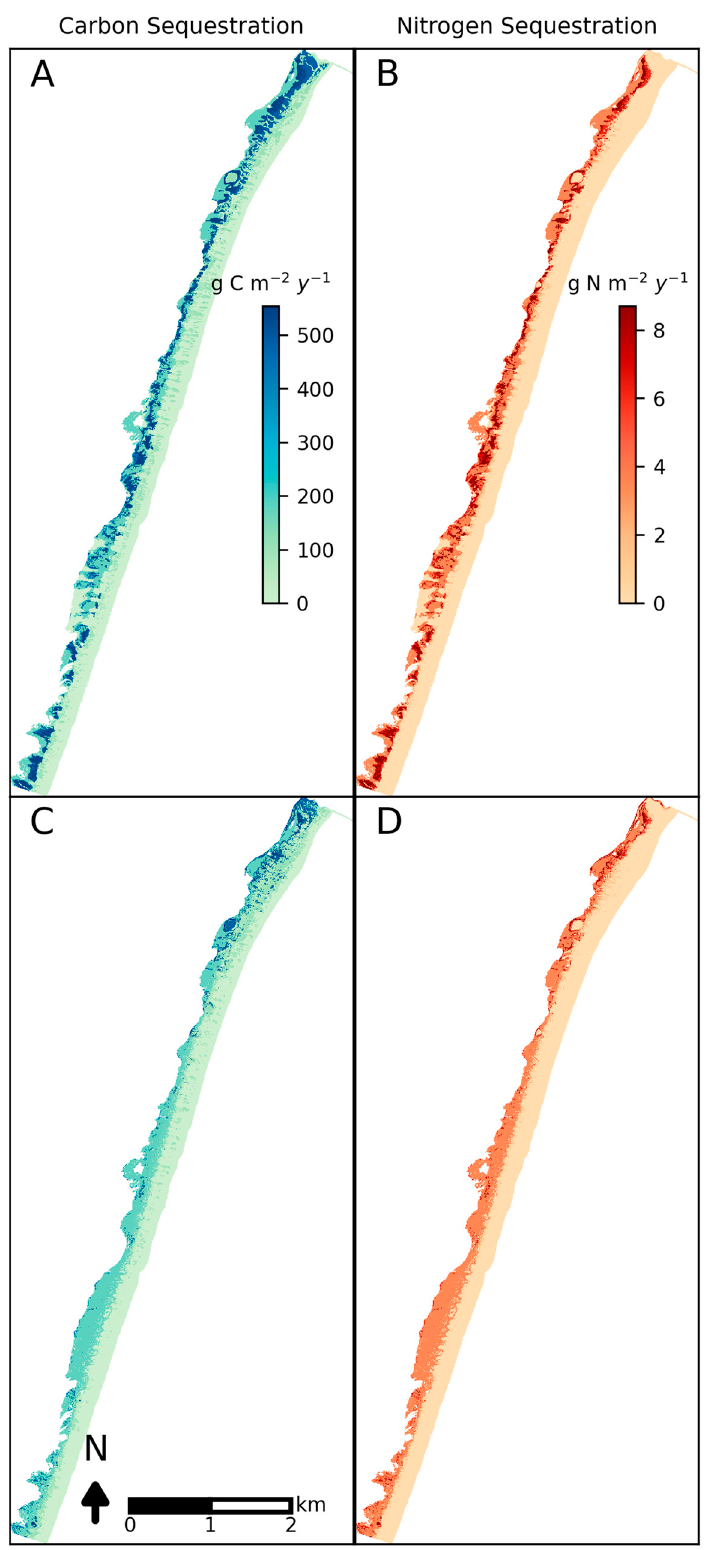
Figure 7. Calculated nutrient sequestration using 2012 DEM and habitat observations for ( A ) carbon and ( B ) nitrogen and using 2012 DEM and habitat model predictions for ( C ) carbon and ( D ) nitro- gen.